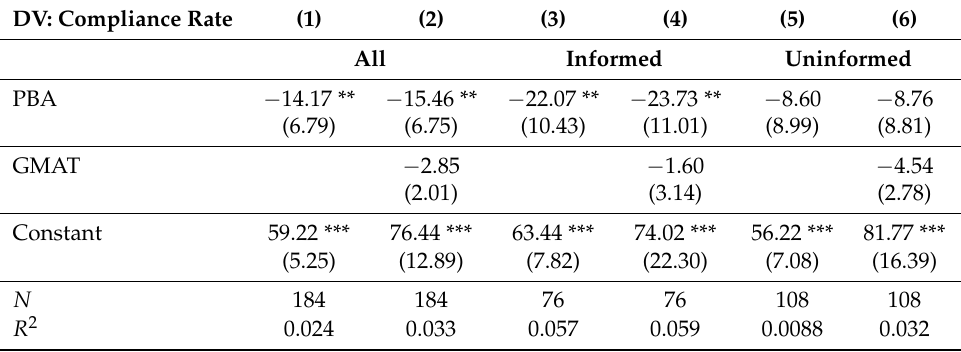
Only low-income taxpayers in groups of four are included. Table A7. Allocation treatment regressions (OLS)—excluding